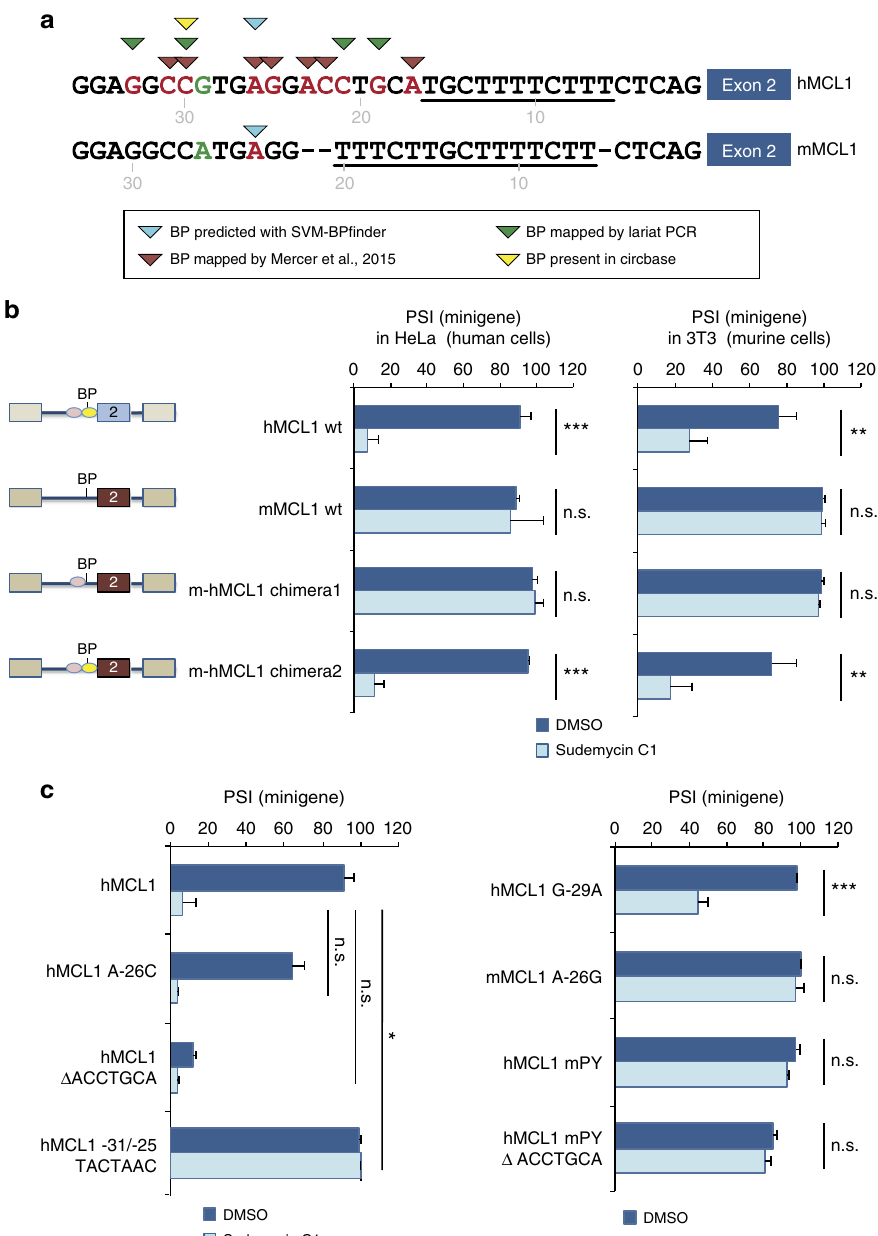
Fig. 2 Differential regulation of human and mouse MCL1 reveals a role for Py-tracts in modulating drug response. a Sequences of the 3 ′ end of human (h) and mouse (m) MCL1 intron 1. Underlined residues indicate the Py-tracts. G/A in green indicates a sequence difference in the 5 ′ part of the region. Residues in red correspond to the predicted BP (for mouse MCL1 ) or mapped BPs (for human MLC1 ) using various strategies, as indicated by the triangles ’ color code. b Distinct effects of Sud C1 on minigenes expression of human or mouse MCL1 transcripts. Minigenes corresponding to the human, mouse or chimeric constructs (containing the indicated regions of human intron 1 replacing the corresponding regions of the mouse transcripts) were analyzed in HeLa (human) or 3T3 (mouse) cell lines as in Fig. 1. Chimera 1: positions − 104 to − 29 from the 3 ′ ss AG of the mouse gene were replaced by sequences − 103 to − 28 of the human gene. Chimera 2: 103 nt of the 3 ′ end of the mouse intron were replaced with the corresponding sequences of the human gene, which include the human BP and Py-tract. Sequences are indicated in Supplementary Table 1. c Assessment of the contributions of various sequence elements to Sud C1 response: Assays were carried out as in b for the indicated mutant constructs. *; **; ***: two-sided t test P value < 0.01, 0.001 and 0.0001, respectively. n.s.: not statistically signi fi cant ( P > 0.01). A minimum of three treatment replicates was used for each condition. Error bars represent s.d. from the mean time frame that allows detection of recently transcribed RNAs, both unspliced and spliced), and BrU-containing RNAs isolated by immunoprecipitation with a speci fi c antibody 35 . BrU was found not to induce signi fi cant changes in the splicing patterns of fully processed RNAs.